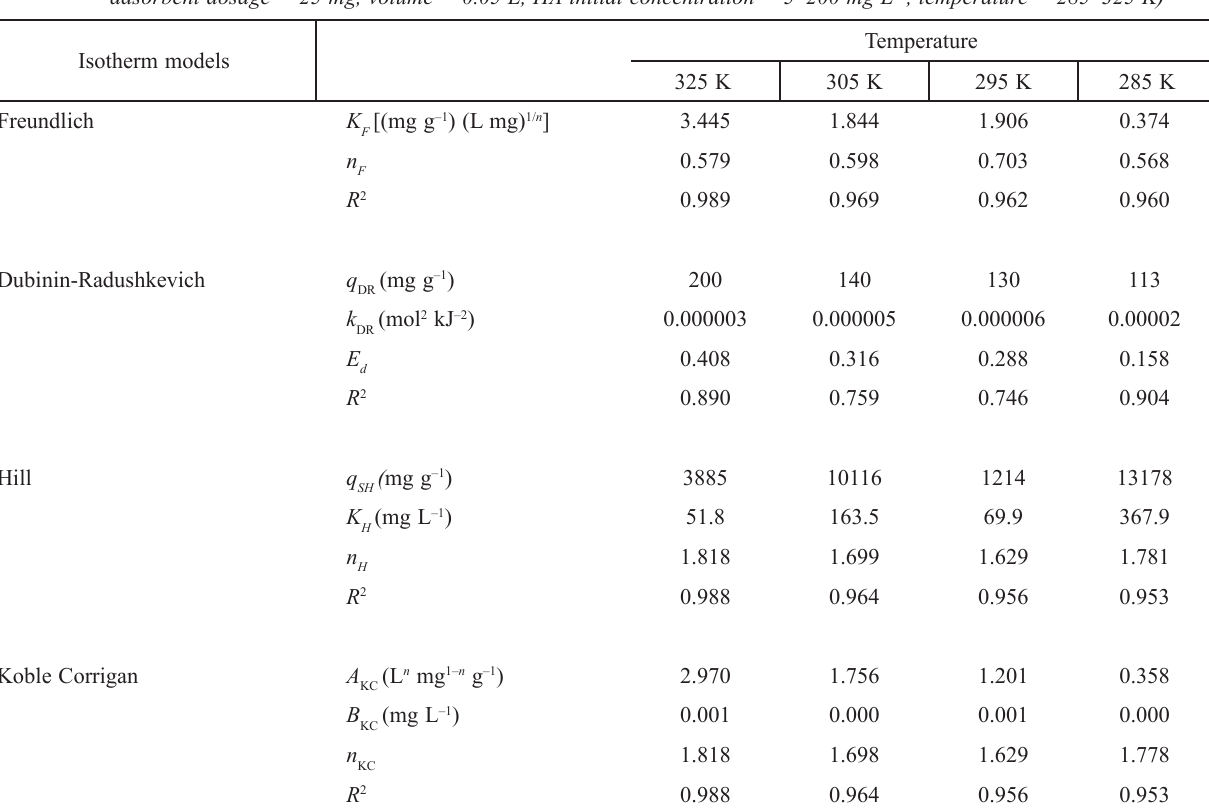
Table 3 – Parameters of isotherm models obtained from nonlinear regression for the adsorption of HA onto Co-MOF (pH = 6, adsorbent dosage = 25 mg, volume = 0.05 L, HA initial concentration = 5–200 mg L –1 , temperature = 285–325 K) Isotherm